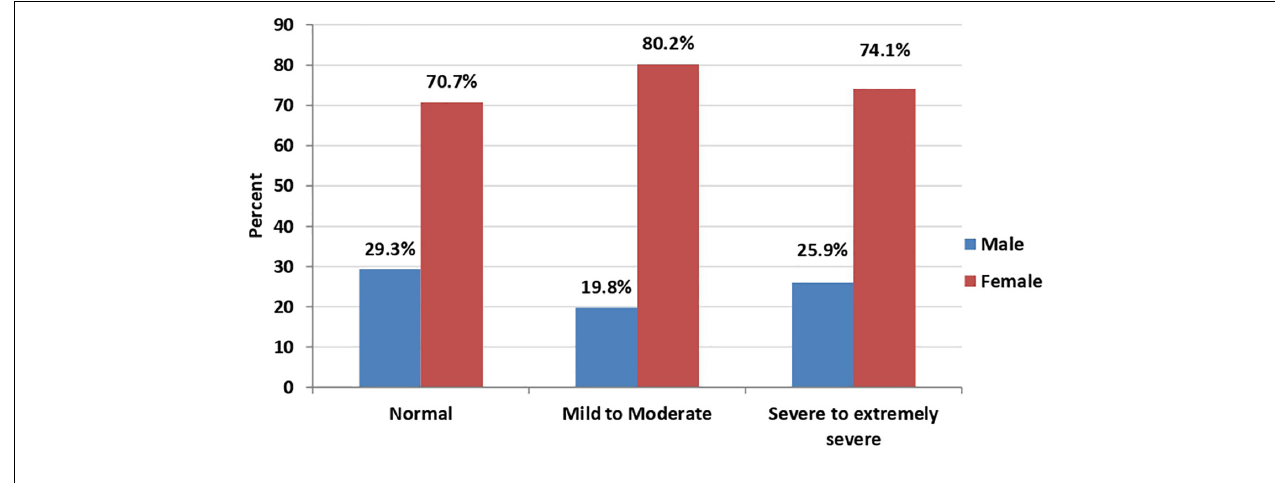
FIGURE 3 | Sex distribution among anxiety severity ( P -value < 0.001; N = 2,819).